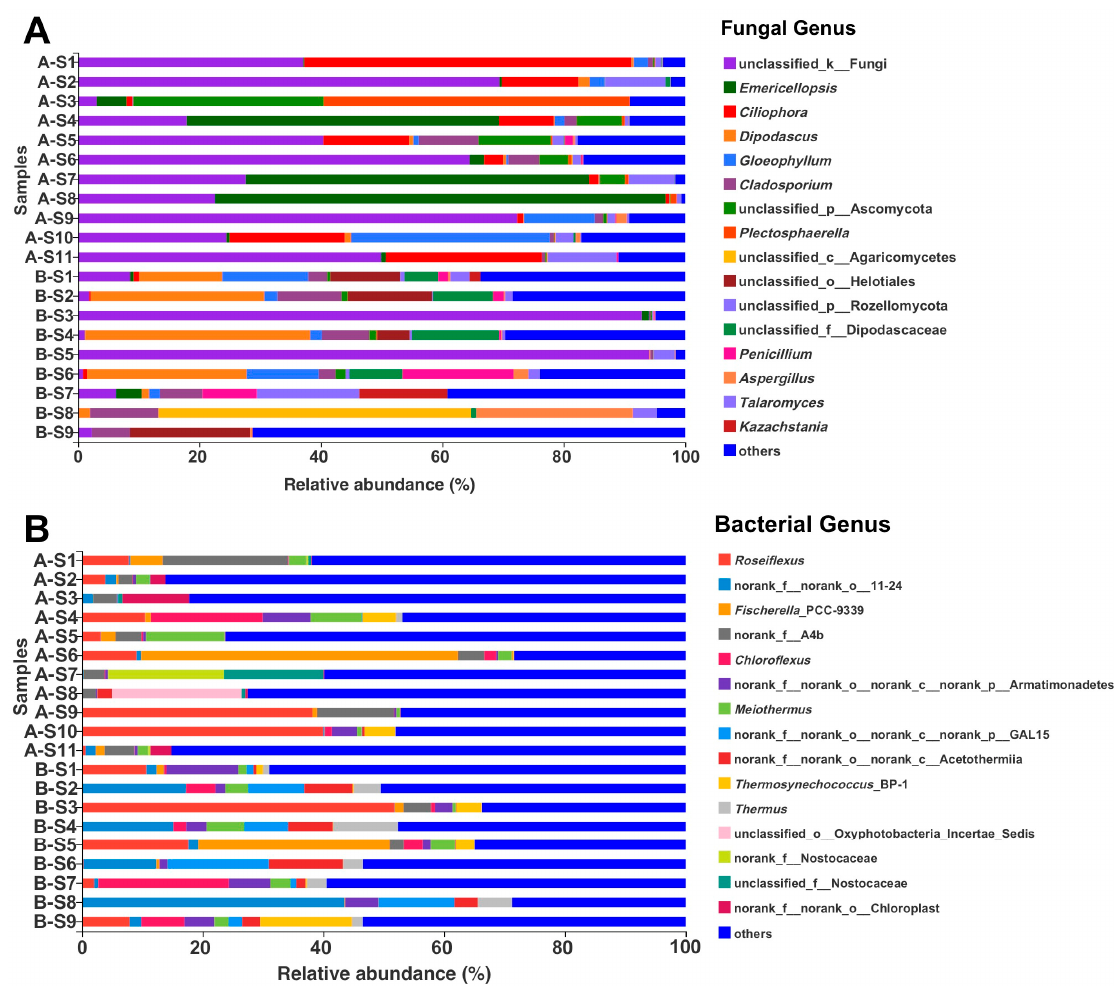
Figure 5. Genus-level relative abundance of fungi ( A ) and bacteria ( B ) from all samples. The relative abundance of fungal and bacterial genera <10% were merged as “others” in the bar plots. Samples A-S1–A-S11 were from Pond A and B-S1–B-S9 from Pond B. In the taxa names, “d” = domain, “k” = kingdom, “p” = phylum, “c” = class, “o” = order, and “f” = family.